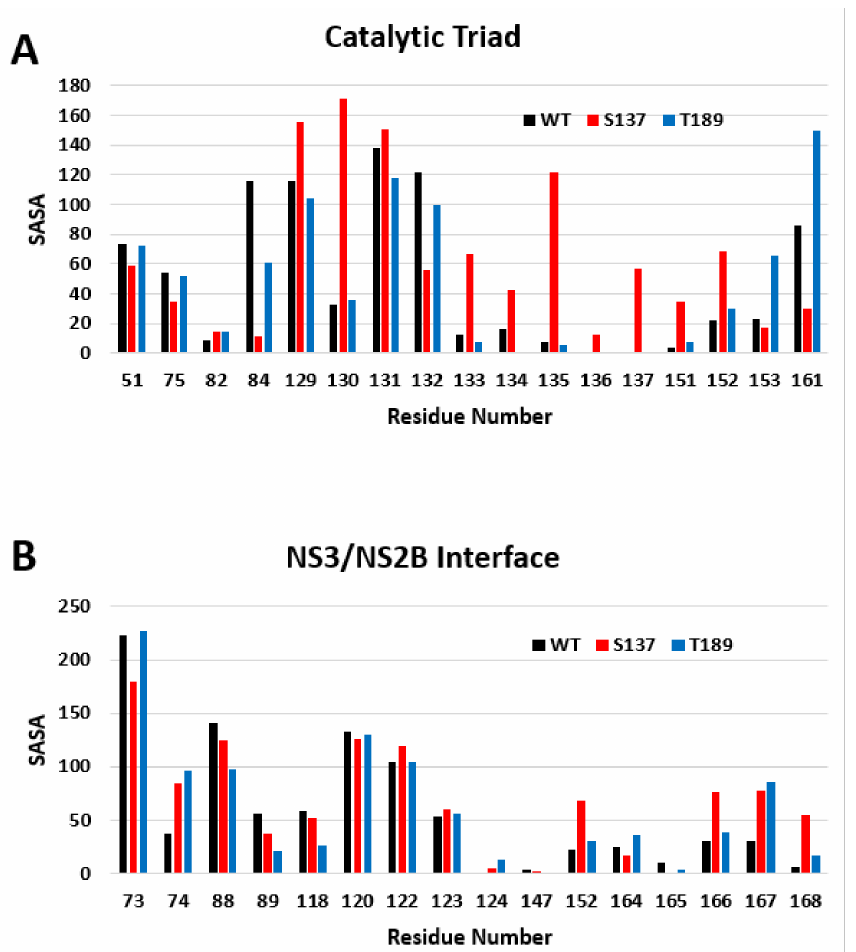
Figure 7. SASA changes of functional domains with phosphorylation. ( A ) The catalytic domain of NS3 shows significant changes with S137 phosphorylation (WT (Black), S137 (Blue), and T189 (Red)). ( B ) The NS3/NS2B interface has only minor changes with